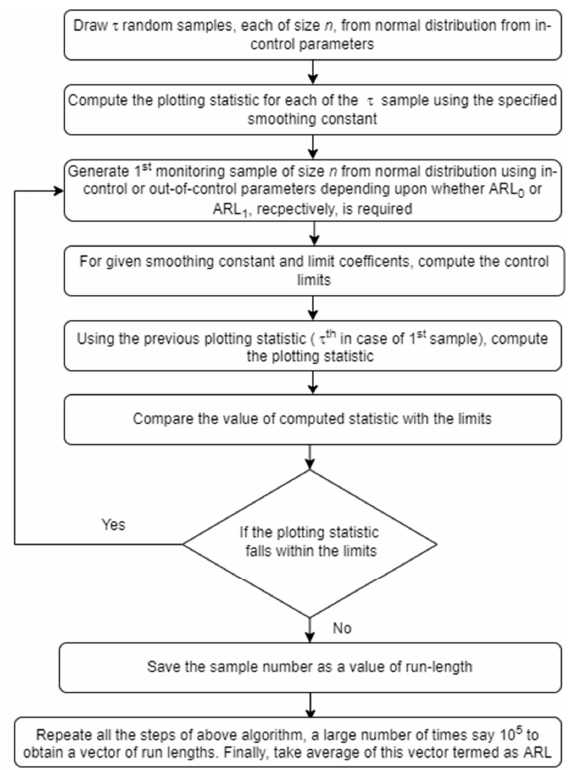
Figure 1. A procedural flow chart of the simulation study.